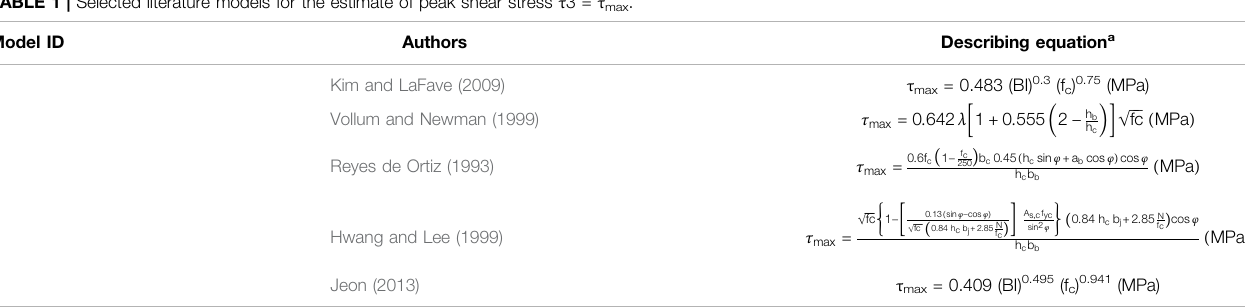
Table 1 provides the equations describing the fi ve models